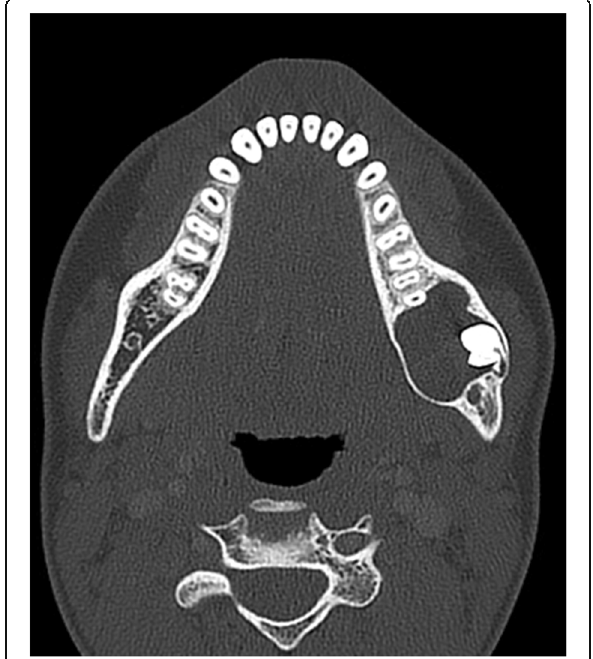
Fig. 6. Odontogenic keratocyst. Axial CT image shows a well- defined expansile lucent lesion in the posterior left mandibular body surrounding the crown of an unerupted molar